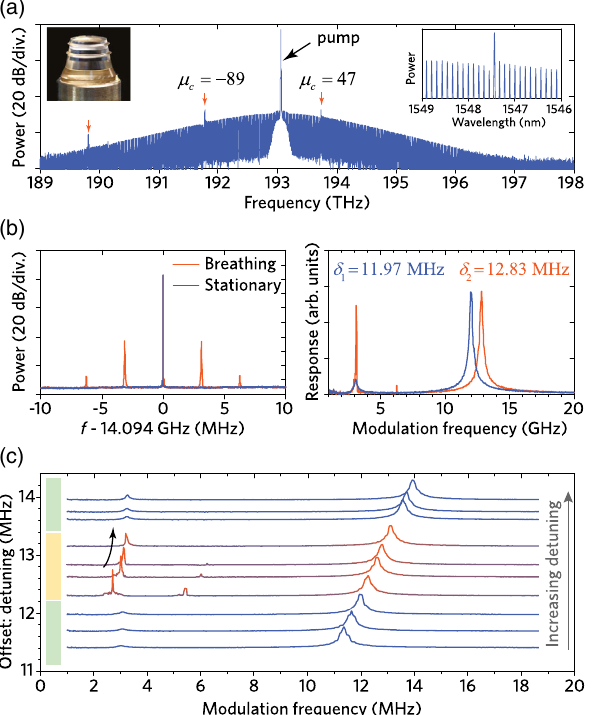
FIG. 2. Observation of an intermode breather soliton in a MgF 2 crystalline microresonator ( ∼ 14 GHz FSR). (a) Experimentally generated single-soliton-based frequency comb exhibiting spikes (i.e., enhanced power in comb teeth) from intermode interactions. ¼ 47 . (b) The beat FIG. 3. Observation of an intermode breather soliton in a chip- Inset: Zoomed-in spectrum around the mode μ c scale Si 3 N 4 microresonator and hysteresis in the comb profile. note measurements (left) and system response measurements (a) Experimentally generated single-soliton-based frequency (right) for both the stationary soliton state and the intermode comb in a silicon nitride resonator (with a ∼ 1 THz FSR) featuring breathing state. (c) Measured evolution of the system ’ s response spikes (i.e., power-enhanced comb teeth) from intermode inter- when increasing the laser detuning. The soliton features breathing actions. (b) Measured evolution of the system response when in the detuning range 12 . 3 – 13 . 2 MHz where a strong frequency increasing the laser detuning. The intermode breathing is in the tone (and harmonics) is observed in the system ’ s response close to detuning range 2.4 – 3.9 GHz. The color bar marks the region of the S resonance. The color bar marks the region of breathing which breathing. (c) Measured power of single comb mode μ is within the stationary soliton existence range. The curved arrow μ ¼ − 25 for both forward and backward laser detuning. The marks the shift of the breathing frequency with an increase of the c measurements reveal a clear hysteresis of the enhanced comb detuning. teeth power (gray